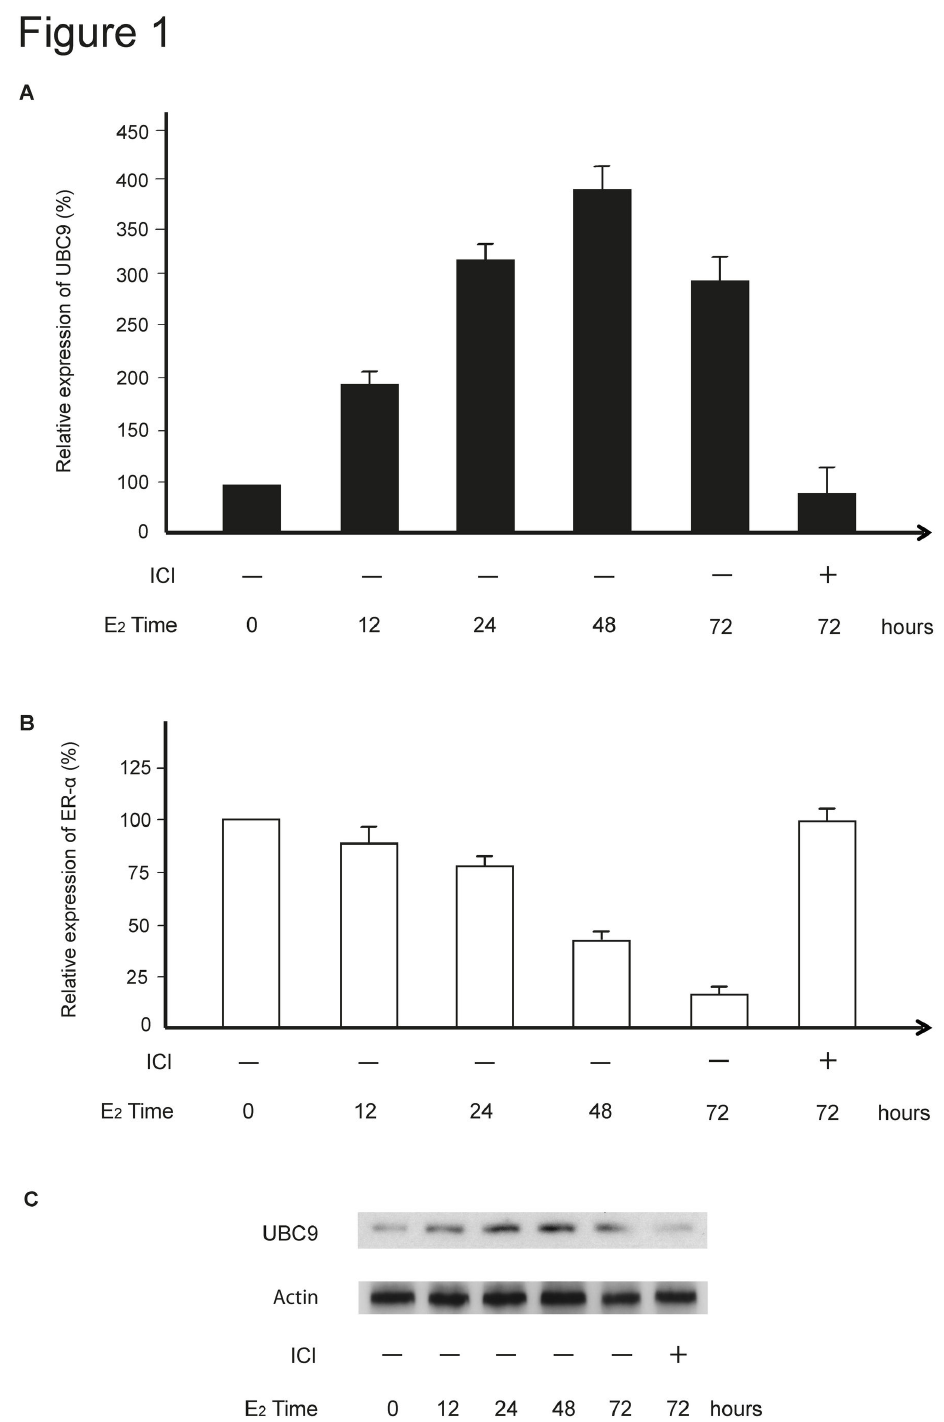
Figure 1. UBC9 expression is up-regulated by E in MCF-7 cells. ( A ) UBC9 and ( B ) ER-α mRNA expression after treatment of 2 MCF-7 cells with 10 nM E for 12, 24, 48 and 72 hours. Where indicated, 100 nM ICI was also added to the culture medium. Total 2 RNA was isolated and analyzed by real-time RT-PCR. Expression levels were normalized to GAPDH expression and relative to expression in untreated cells, which was arbitrarily set to 1. The data refer to results obtained in four separate experiments performed in triplicate. Bars represent the standard deviation (SD). ( C ) Up-regulation of UBC9 protein levels after induction with E Total protein was extracted and analyzed by Western blotting. Actin was used as an internal protein loading control. doi: 10.1371/journal.pone.0075695.g001 PLOS ONE |